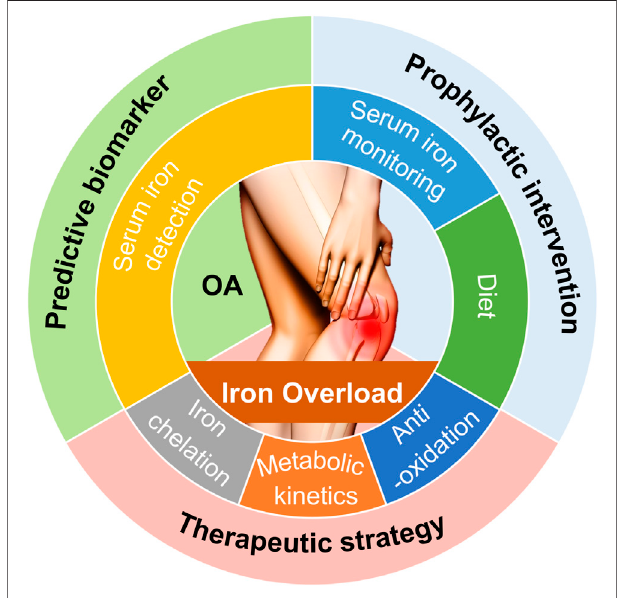
FIGURE3| Potentialclinicalinterventionsand valueassociatedwithiron overload used for predicting, preventing, treating OA. Based on the principles for iron overload-modulated OA pathogenesis that we have discussed, potential clinical interventions and value for OA include predictive biomarker, prophylactic intervention, and therapeutic